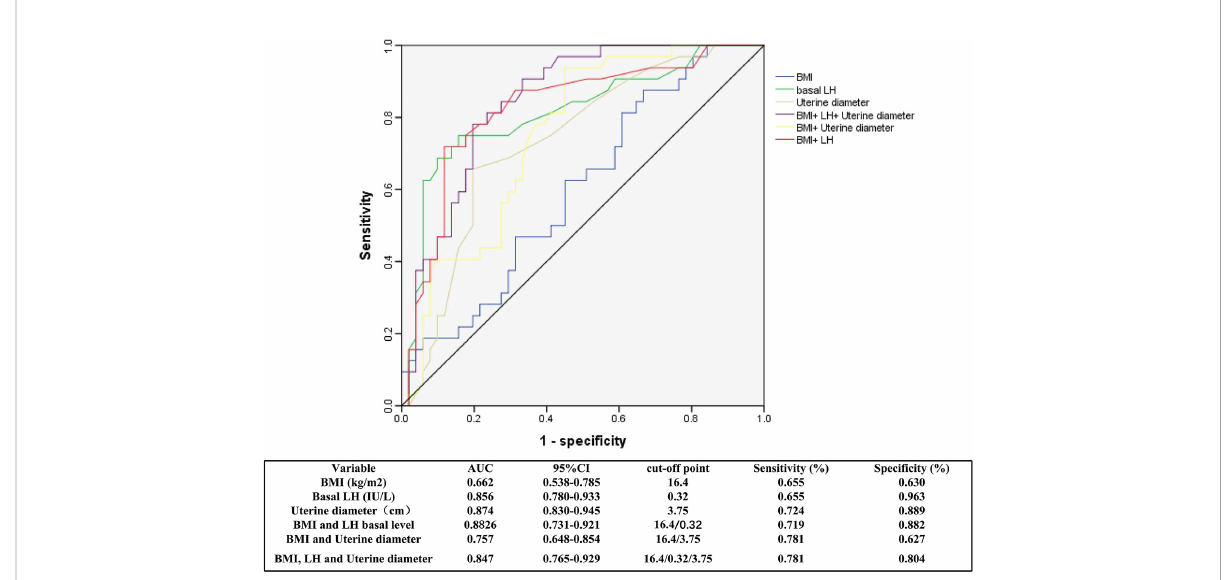
FIGURE 4 Receiver operator characteristic curves of BMI, basal LH and uterine diameter for the diagnosis of CPP. ROC, receiver operating characteristic; AUC, area under the curve; BMI, body mass index; LH, luteinizing hormone; CPP, central precocious